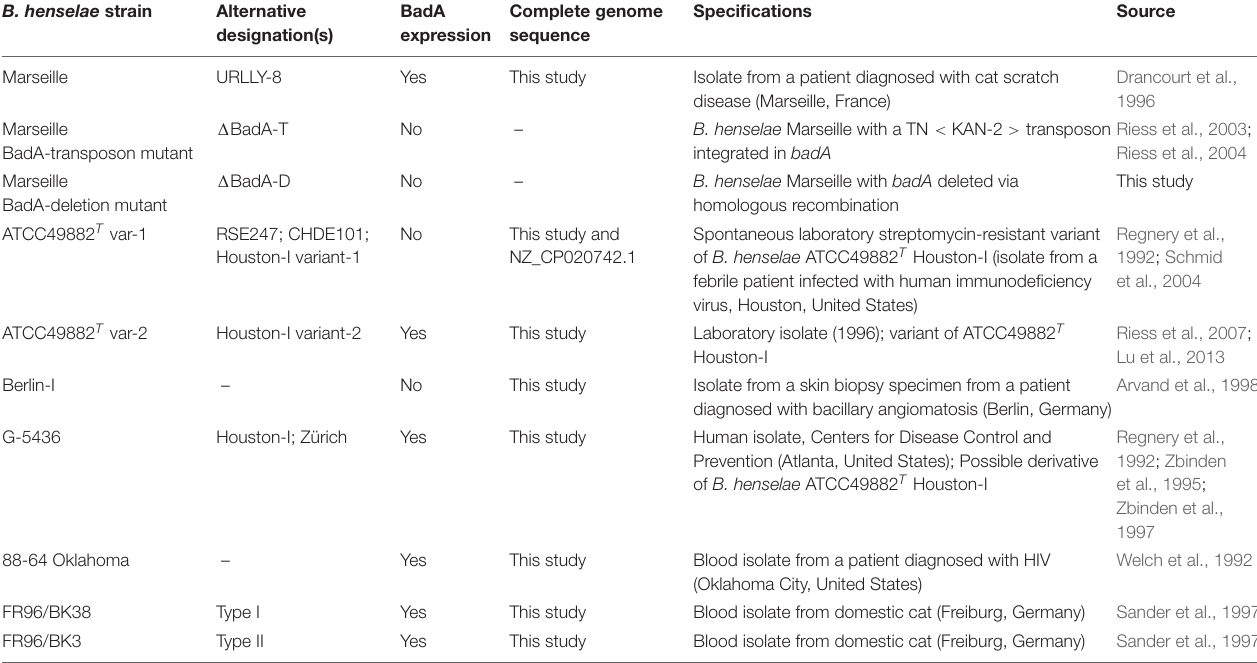
TABLE 1 | Overview of B. henselae strains used in this study a